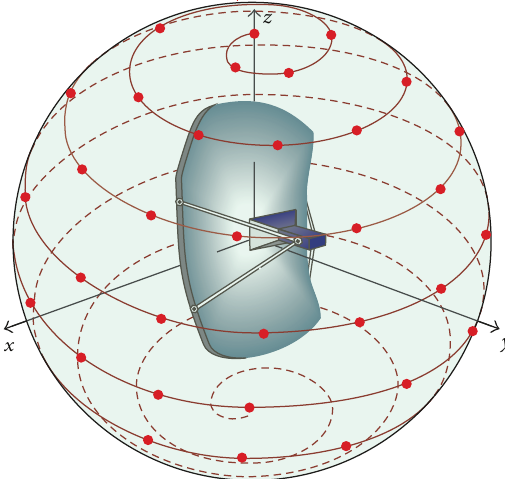
Figure 3: Spherical spiral